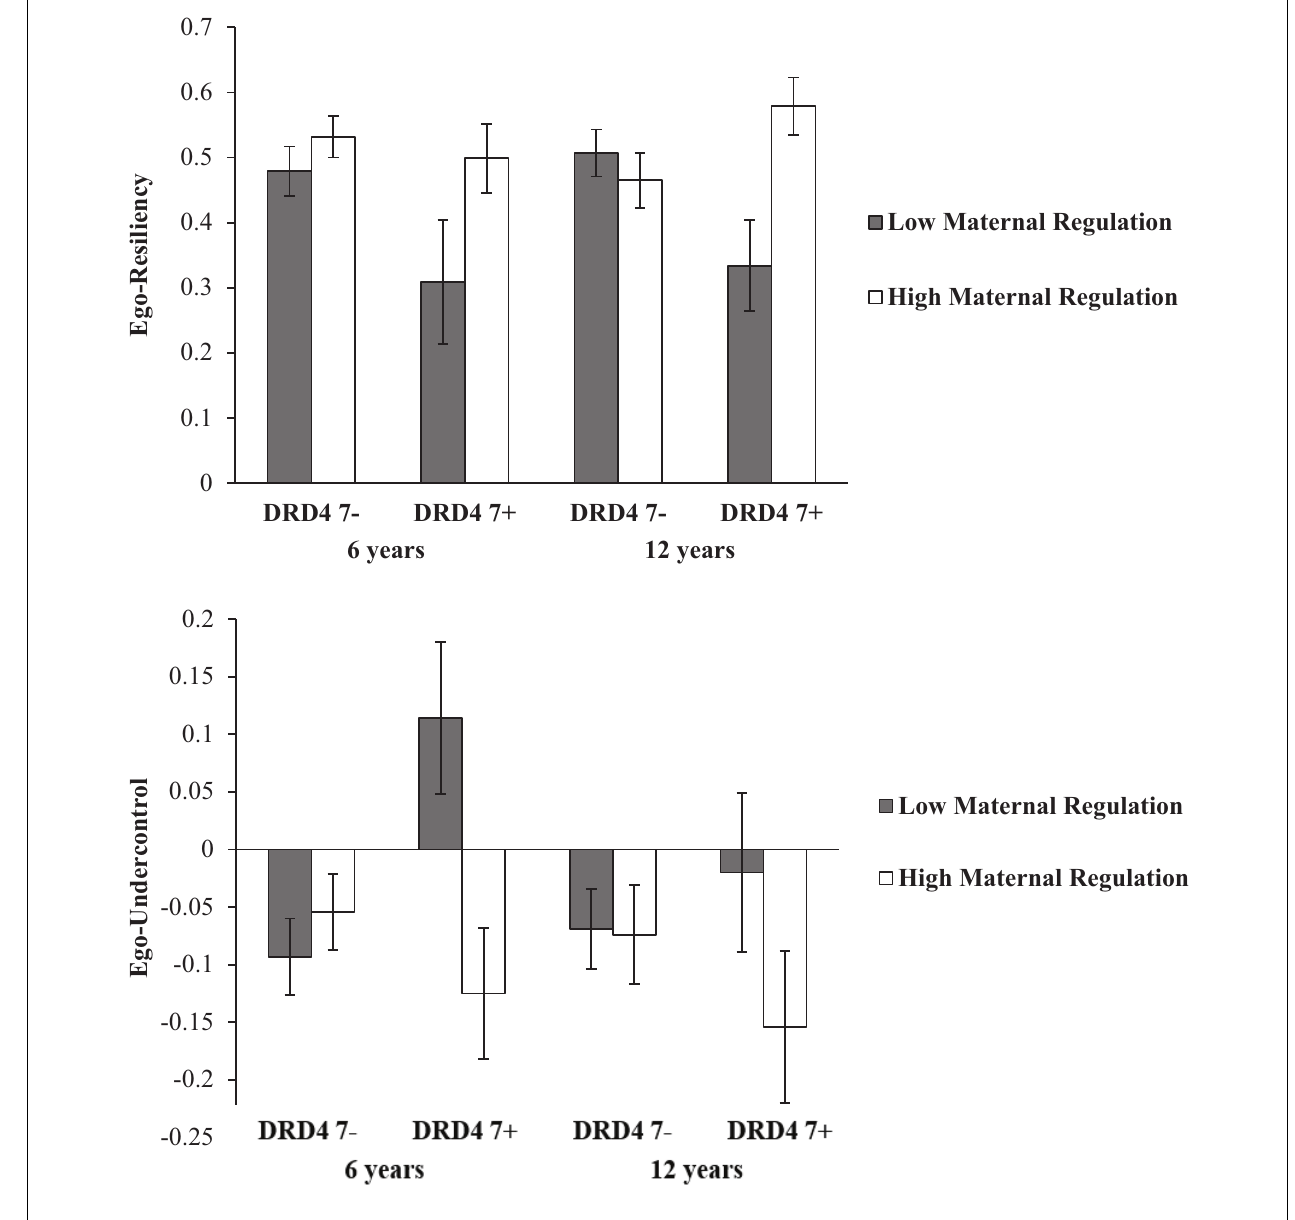
FIGURE 1 | Children’s Means (and SE) in ego-resiliency and ego-undercontrol according to DRD4 polymorphism and maternal regulation.